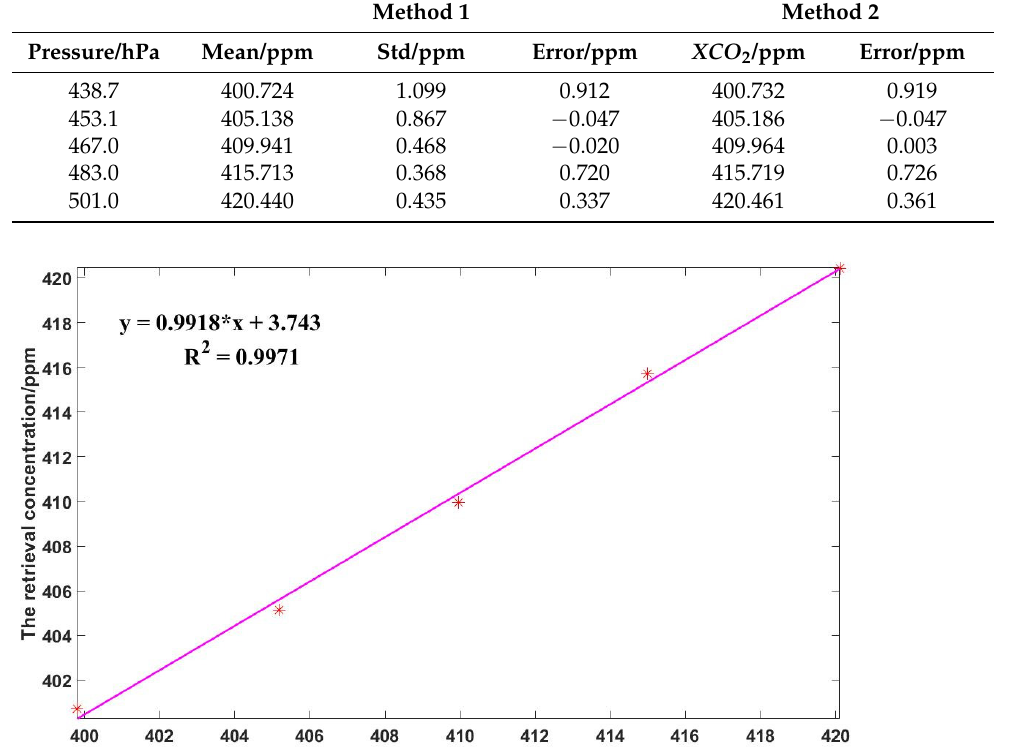
Figure 14. Linear fit of true and retrieval concentrations. The red * indicates the retrieval concen- tration corresponding to each true concentration. Table 8. Comparison of retrieval results.